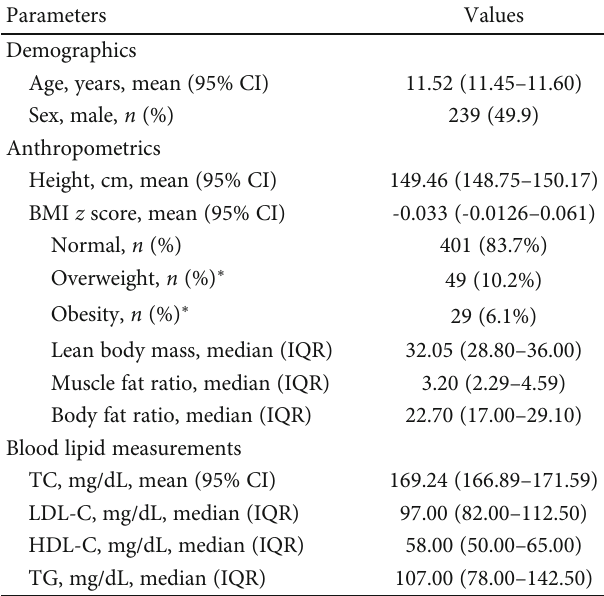
Table 1: Demographic and clinical characteristics of the participants ( N = 479 ).